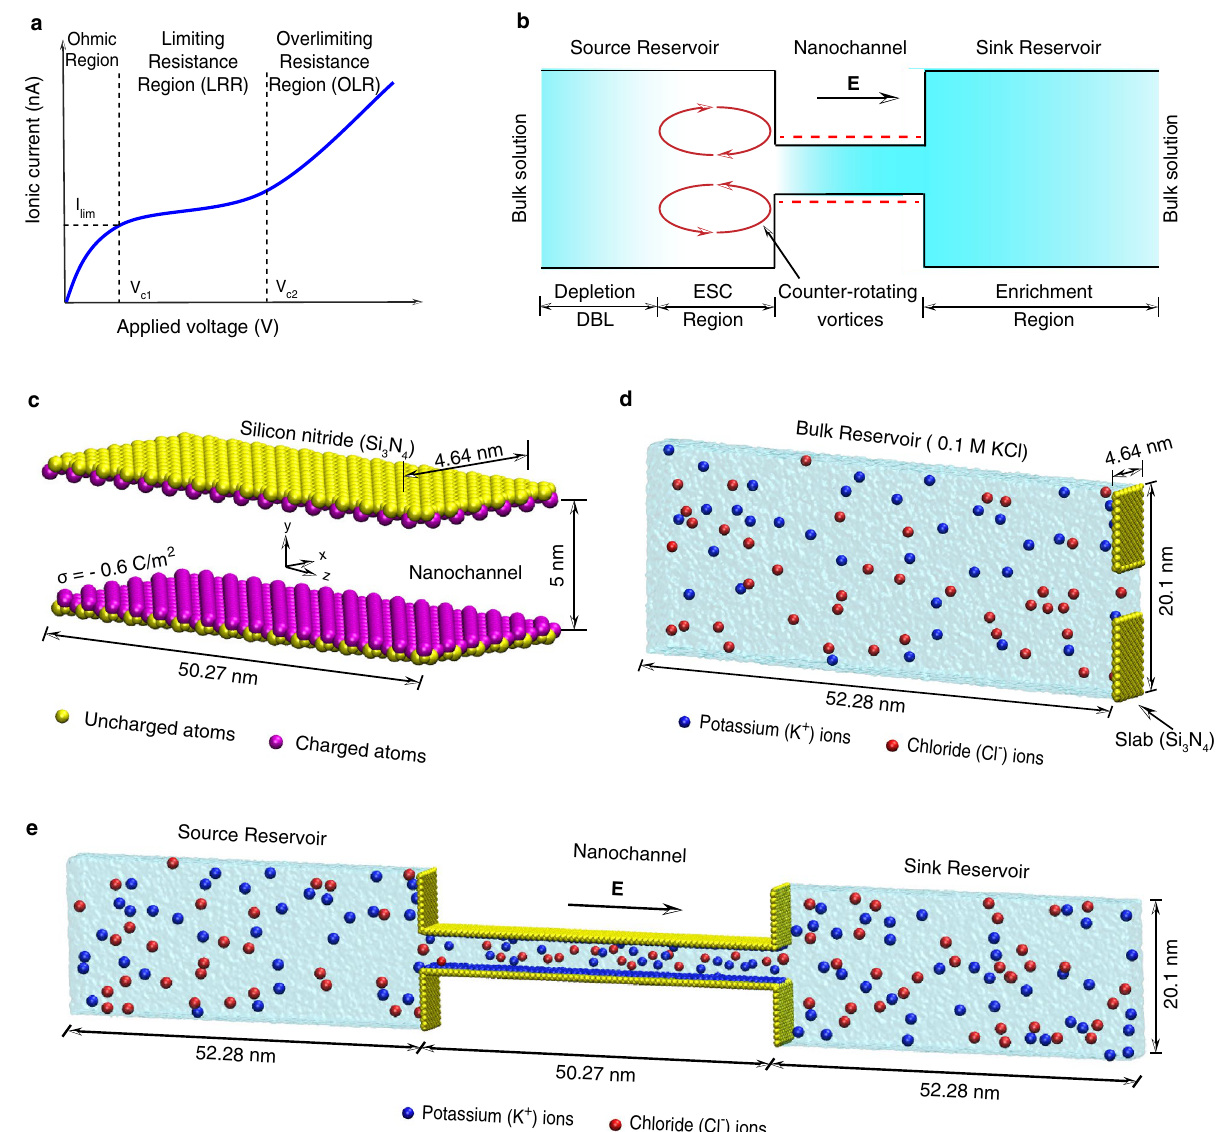
Figure 1. ( a ) The schematic diagram of the typical I-V behaviour of the ion exchange devices. ( b ) shows the sketch of the various regions in the nanochannel integrated system under non-ohmic regions. ( c ) shows a silicon nitride nanochannel of height 5 nm used in all-atom MD simulations. To obtain the desired surface 2 charge ( σ = − 0.6 C / m ) of the nanochannel, the additional charges are added to the surface atoms along with its partial charge. ( d ) shows the bulk reservoir filled with 0.1 M potassium chloride (KCl) solution. The silicon nitride slab is used to guide the flow through the nanochannel from the bulk reservoir. ( e ) The final assembled view of the simulation system. Semitransparent surface shows the volume filled with water molecules. For clear visualization, we showed only a few number of ions in the system. Dimensions in the figure show the size of the system after 5 ns of NPT simulation. Drawings in ( c – e ) were created using VMD software (www. ks. uiuc. edu/ Devel opment/ Downl oad/ downl oad. cgi? Packa geName= VMD and version